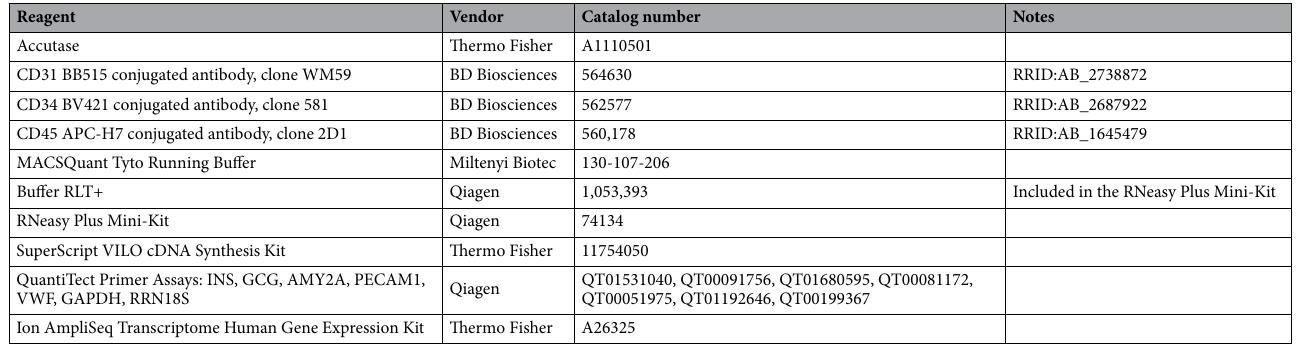
Table 2. Reagent